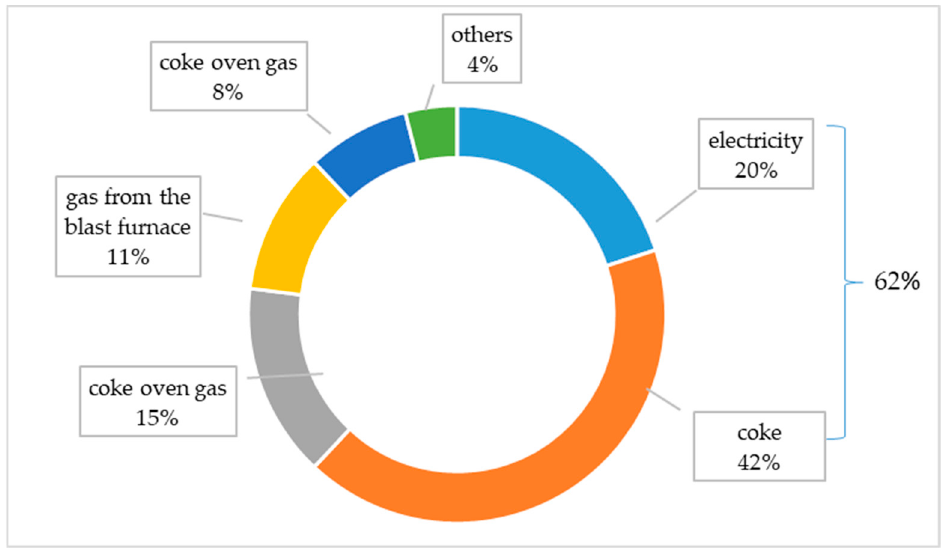
Figure 1. Structure of consumption of energy media in the steel industry in Poland. Source: [59].